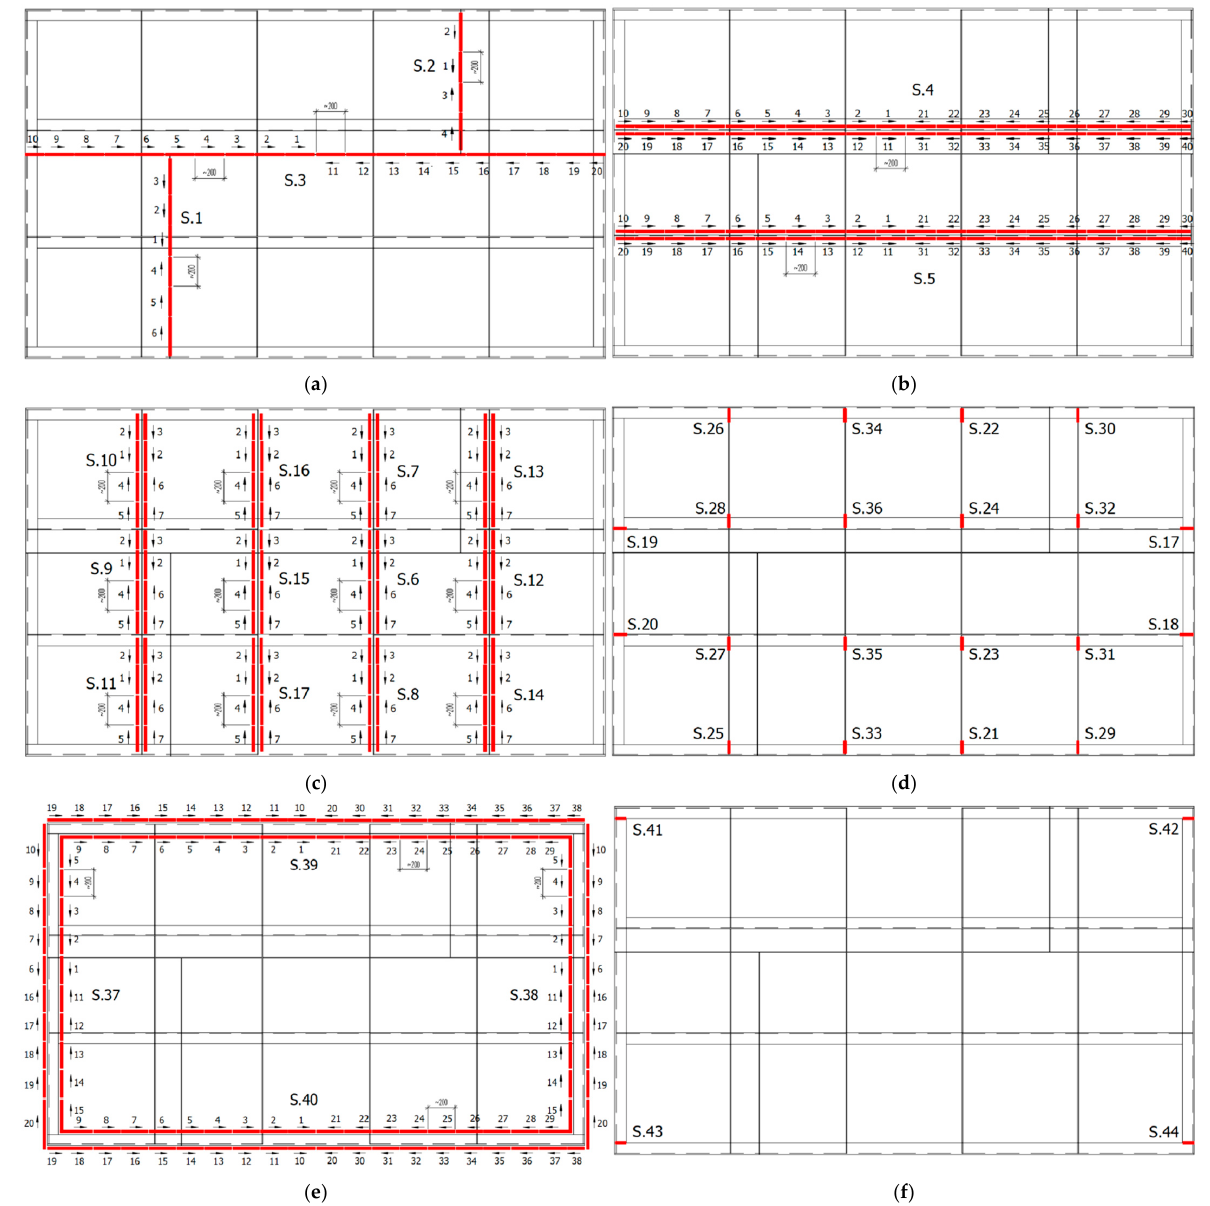
Figure 3. Sequence of welds in the numerical simulation of the welding process of the industrial furnace wall panel; ( a ) welds S.1–S.3 joining metal sheets (stage 1), ( b ) welds S.4 and S.5 joining ribs made of angles to the metal sheets (stage 2), ( c ) welds S.6–S.17 joining the ribs made of flat bars to the metal sheets (stage 3), ( d ) welds S.18–S.36 joining the ribs made of flat bars to the channel sec- tions of the frame and ribs made of angles (stage 4), ( e ) welds S.37–S.40 joining the channel sections of the outer frame to the metal sheets (stage 5), and ( f ) welds S.41–S.44 joining the channel sections of the outer frame (stage 6).